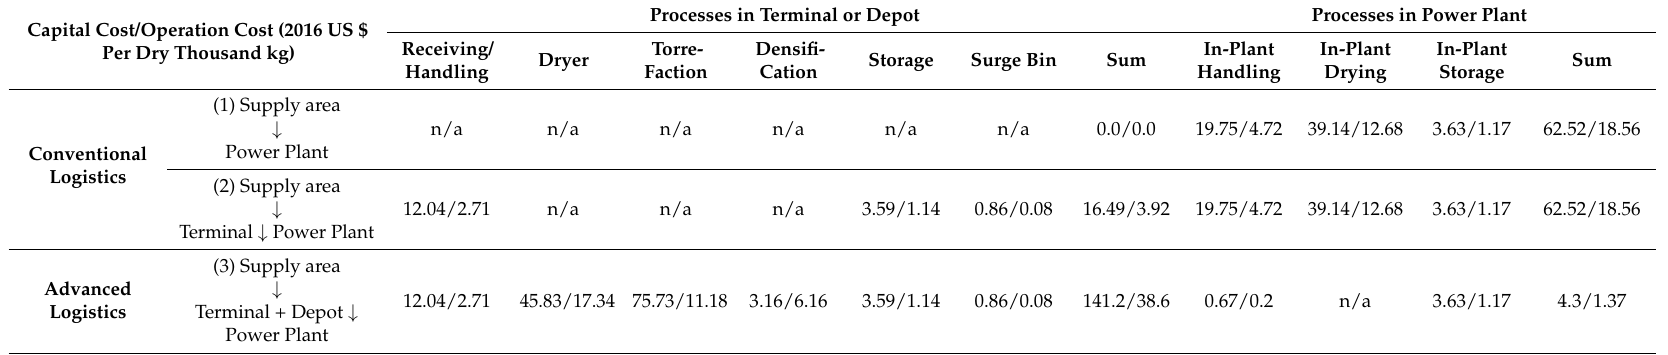
Table A2. Capital and operation costs of conventional and advanced logistics for woody biomass co-firing (Ko and Lautala